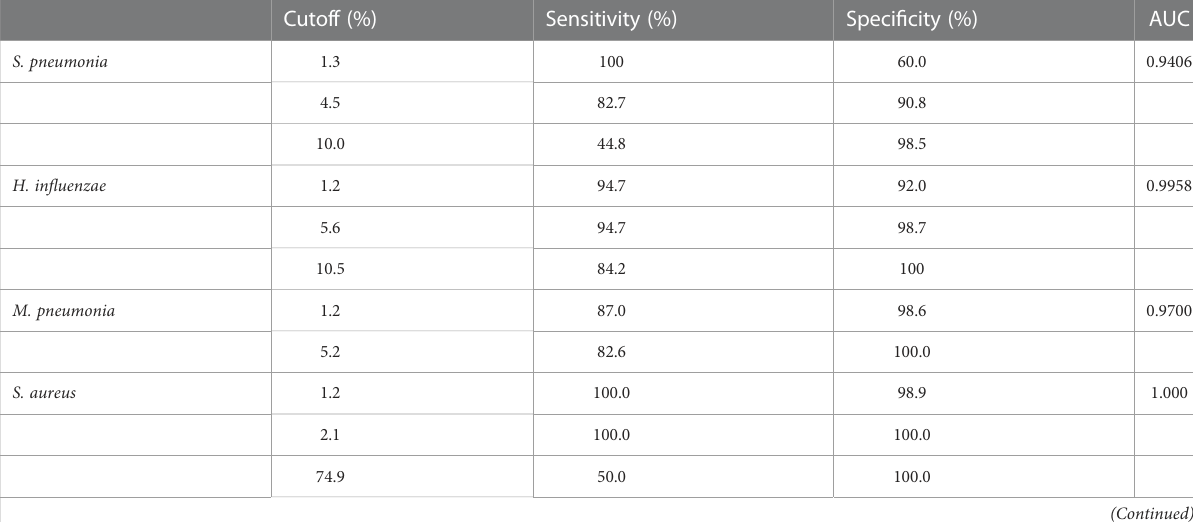
TABLE 3 The relationship between the NB16S-seq abundance threshold and the sensitivity and speci fi city for different strains according to the gold standard test (either culture or PCR) results. Cutoff (%) Sensitivity (%) Speci fi city (%)